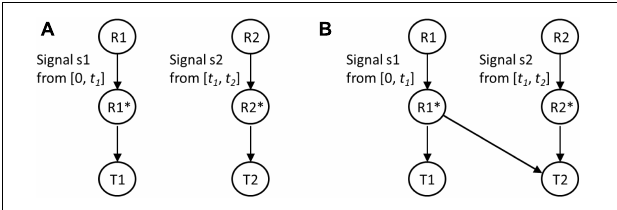
FIGURE 1 | Regulatory designs without (A) and with (B) anticipatory regulation. In the prevailing environment, signal s1 is present from [0, t1 ] and signal s2 is present from [ t1 , t2 ]. In the first design, activated regulator R1 ∗ controls expression of target protein T1, and R2 ∗ controls expression of T2. In the second regulatory design, R1 ∗ , in addition to controlling expression of T1, also partially/fully controls expression of target protein T2.